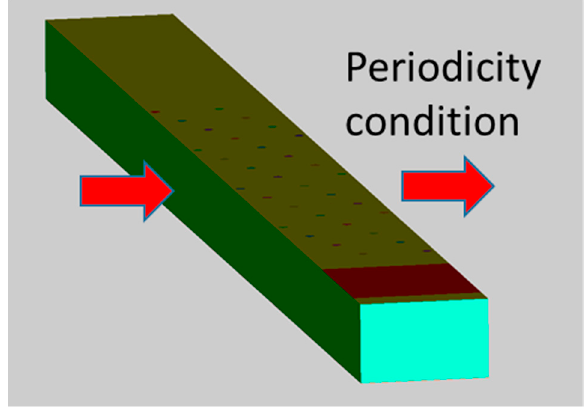
Figure 13. Overall 3D geometry.